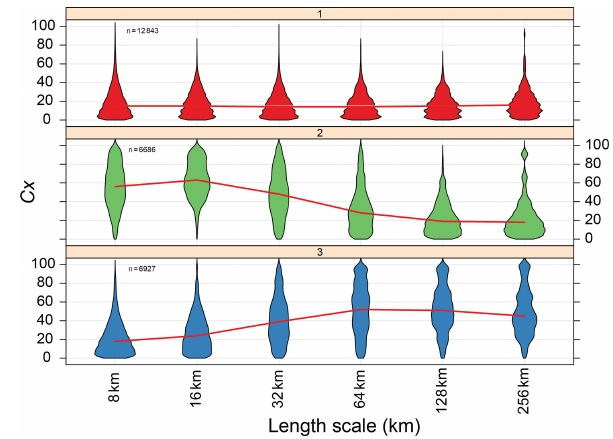
Figure 7. Violin plots of C x magnitude values for ≥ 8km length scales, showing three-group structure determined by k -medoids clustering. The red line joins adjacent median values in each distri- bution. Panel numbers indicate group number and are comparable with group numbers in allied